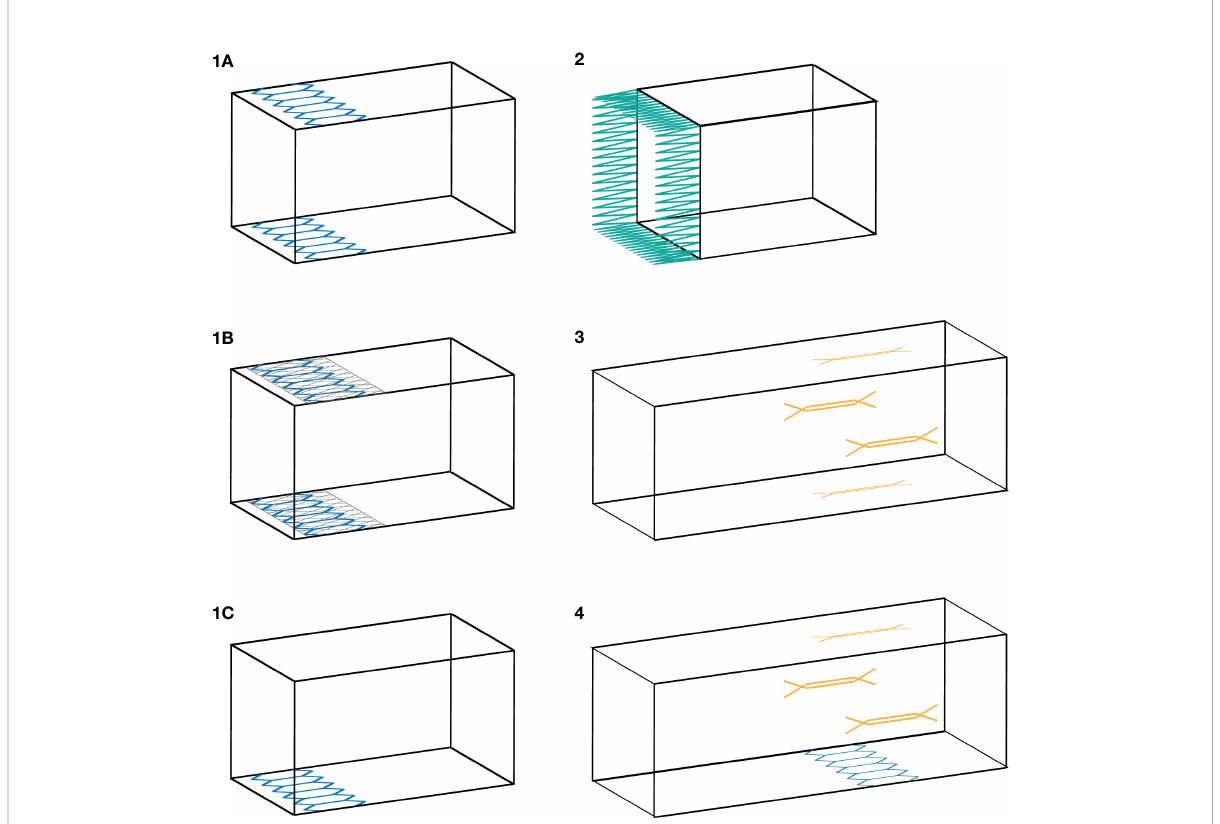
FIGURE 2 (1A) Section with hexagonal meshes in the front (top and bottom panels); (1B) Section with hexagonal meshes in the front (top and bottom panels), loose small-meshed netting covers the openings. (1C) Section with hexagonal meshes in the front, bottom panel only. (2) section with large meshes in the front (all four panels); (3) section with slots (all four panels); and (4) section with slots (top and side panels) and hexagonal meshes in the bottom.